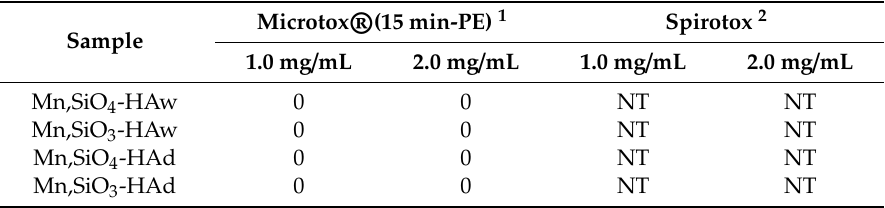
Table 3. Toxicity of the synthesized powders in Microtox ® and Spirotox